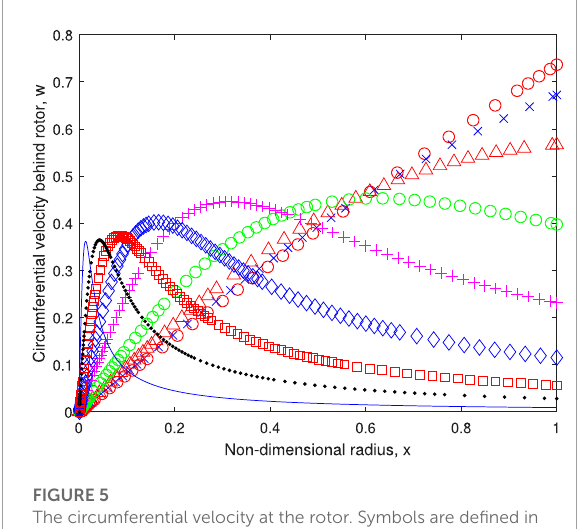
FIGURE 6 Test of helical symmetry. Symbols are defined in Table 1